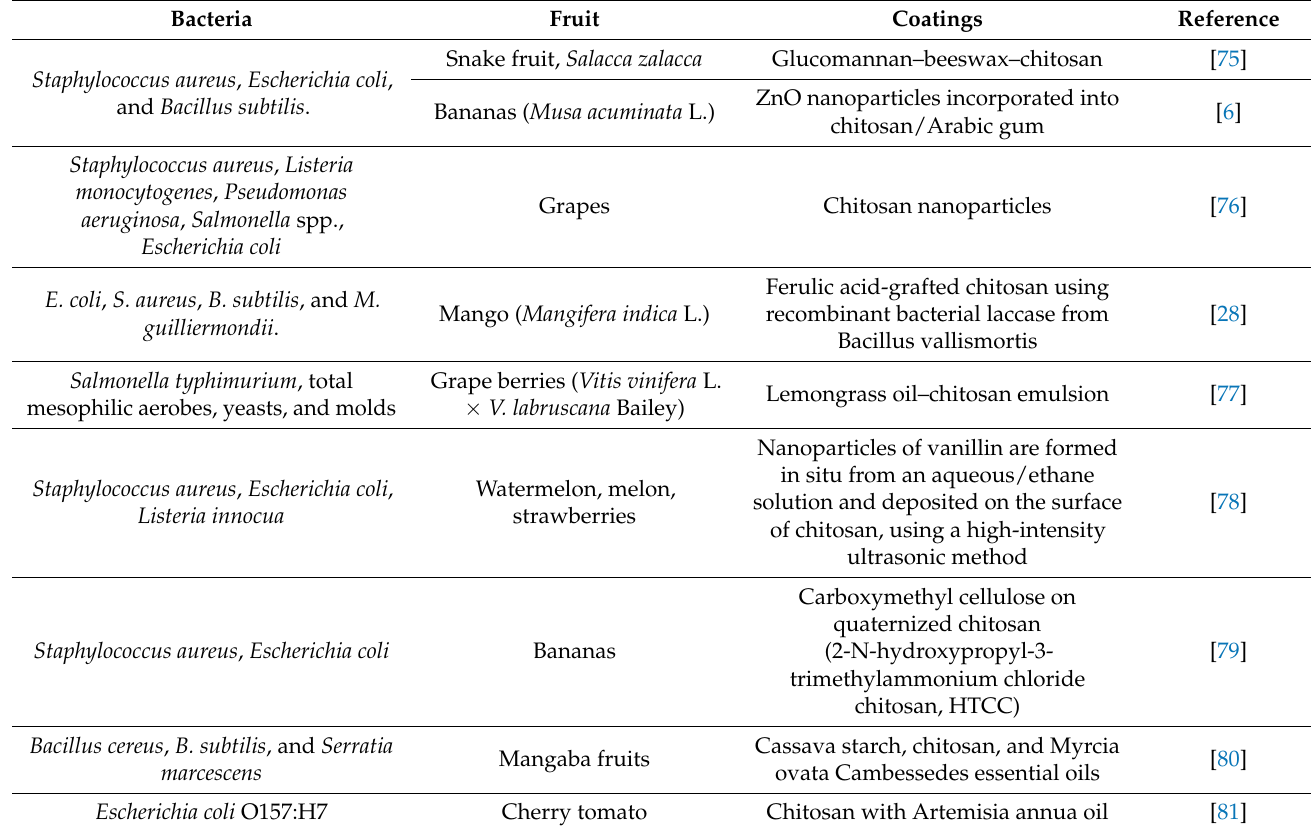
Table 3. Published results of bacterial contamination by different microorganisms in fruits: from 2011 to 2021.